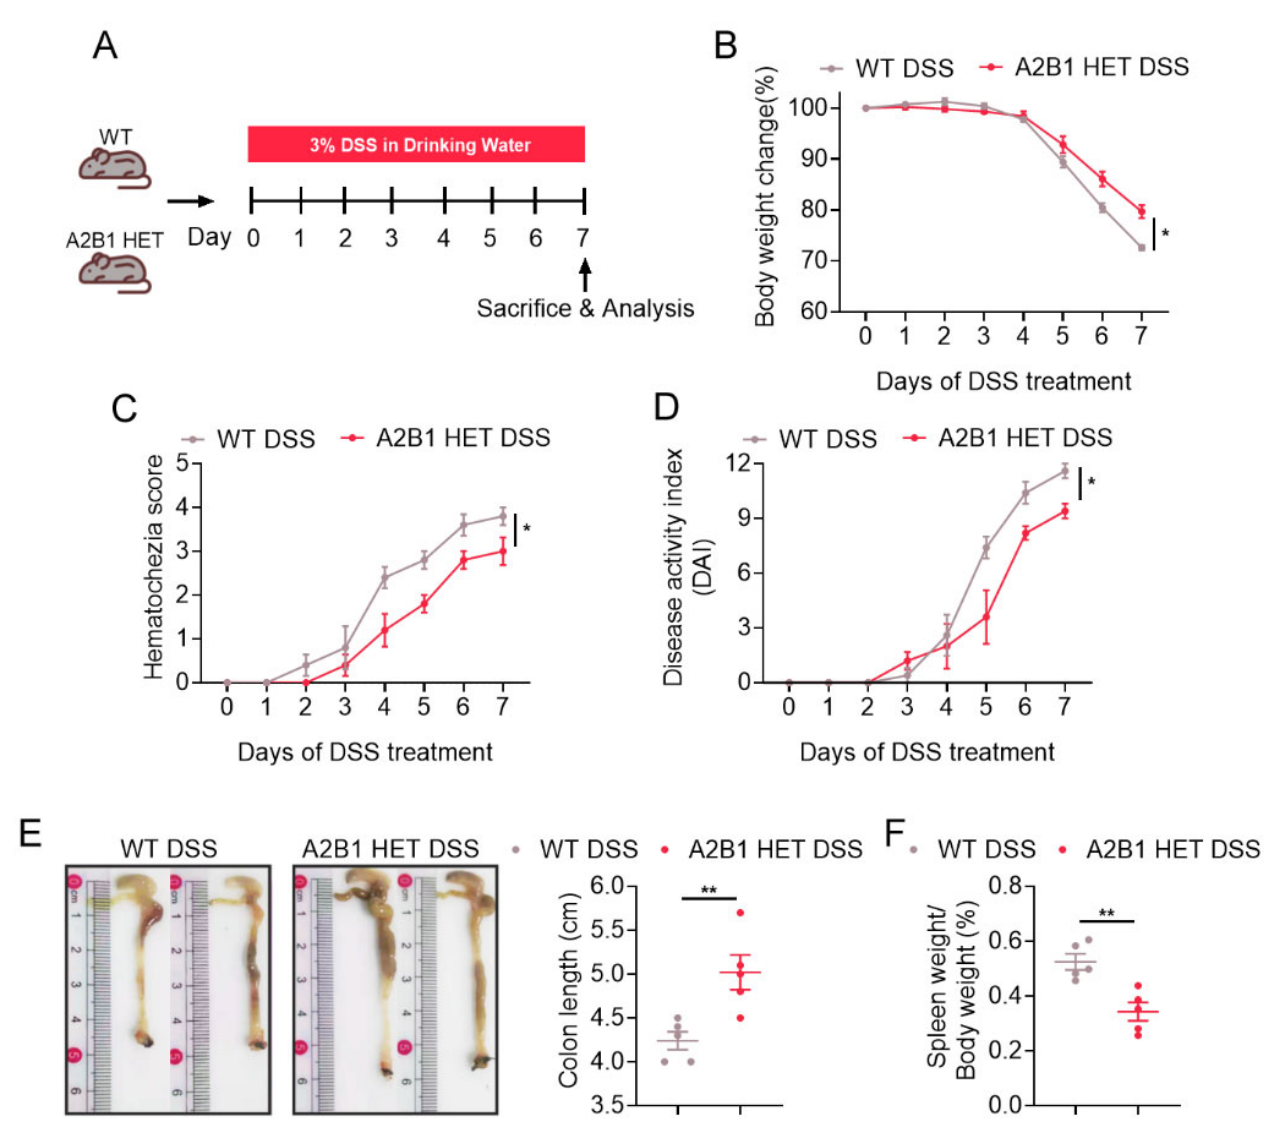
Figure 2. hnRNPA2B1 deficiency protects mice from DSS-induced acute colitis. ( A ) Schematic representation of the experimental design and timeline. ( B ) Percentage of body weight change from baseline after 3% DSS administration. ( C ) Hematochezia scores of DSS-treated WT and A2B1 HET mice. ( D ) Disease activity index (DAI) of DSS-treated WT and A2B1 HET mice. ( E , F ) Colon length ( E ) and spleen-to-body-weight ratio ( F ) of DSS-treated WT and A2B1 HET mice seven days post IBD induction. Results are shown as mean ± SEM; * p < 0.05, ** p < 0.01.